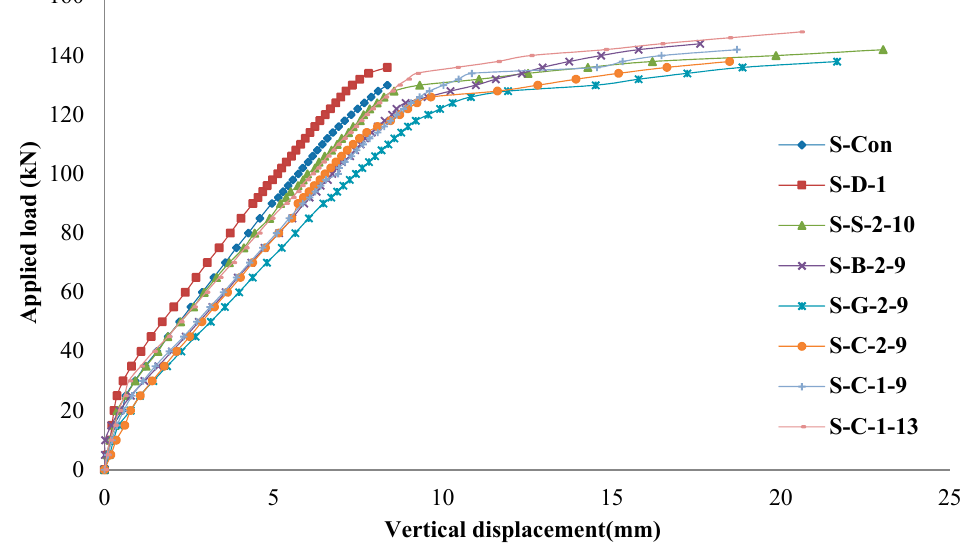
Figure 11. Comparisons of load vs. vertical deflection at loading point in test slabs.